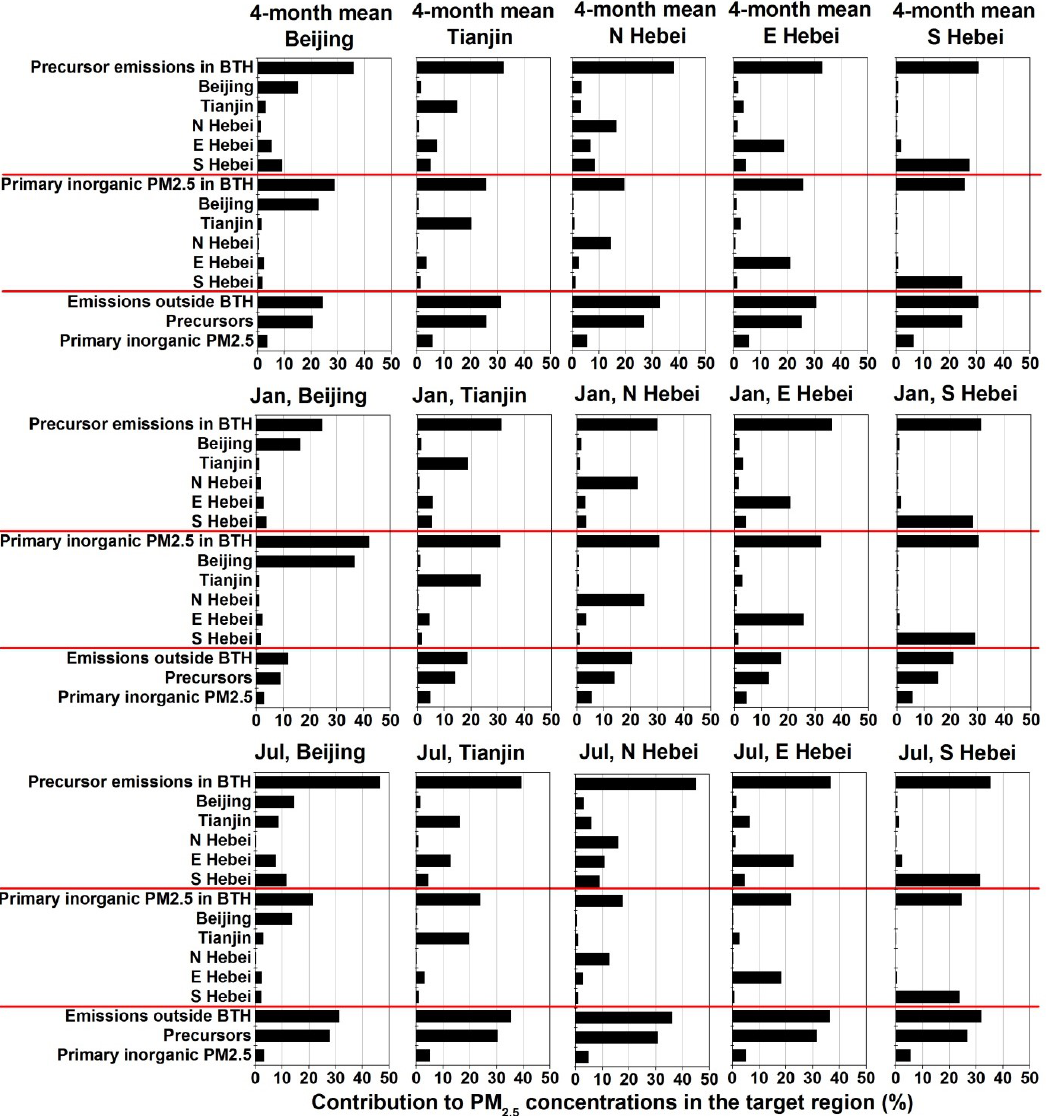
Figure 6. Contributions of precursor (NO x , SO 2 , NH 3 , NMVOC, IVOC, and POA) and primary inorganic PM 2 . 5 emissions from individual regions to PM 2 . 5 concentrations. The contributions are quantified by comparing the base case with sensitivity scenarios in which emissions from a specific source are reduced by 80%. This figure illustrates contributions to 4-month mean PM 2 . 5 concentrations and monthly mean PM 2 . 5 concentrations in January and July. The results for March and October are given in Fig. S6.